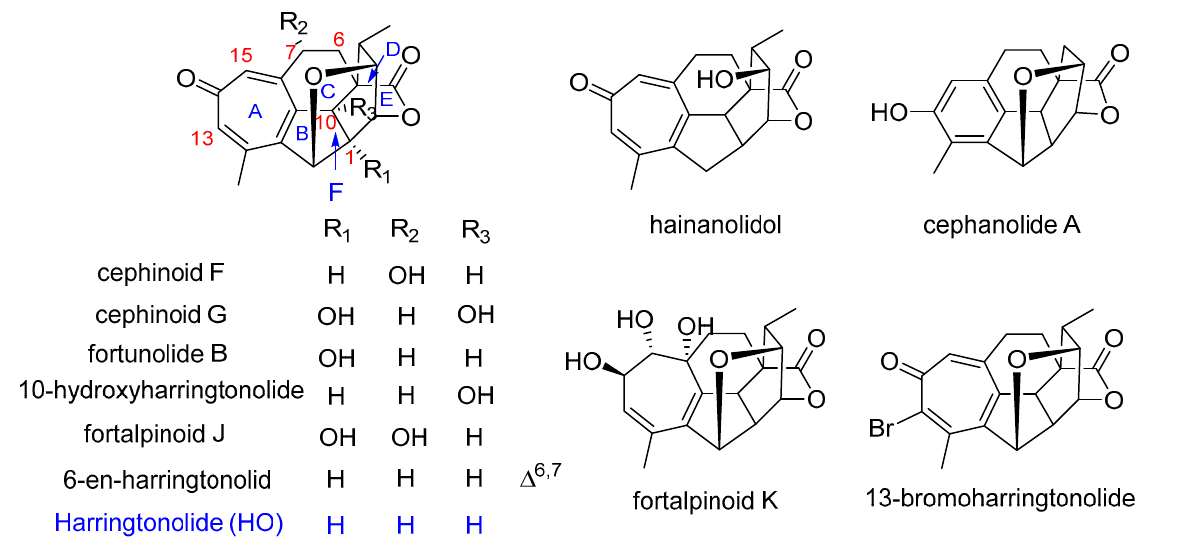
Figure 1. Structures of harringtonolide and its analogues.